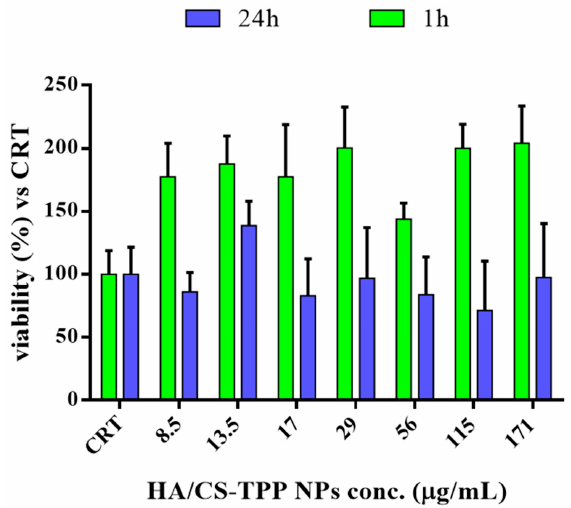
Figure 4. Cytotoxicity of placebo HA/CS-TPP NPs at 1st and 24th h of incubation with normal human dermal fibroblasts (NHDFs) compared to untreated control (CRT) cells.